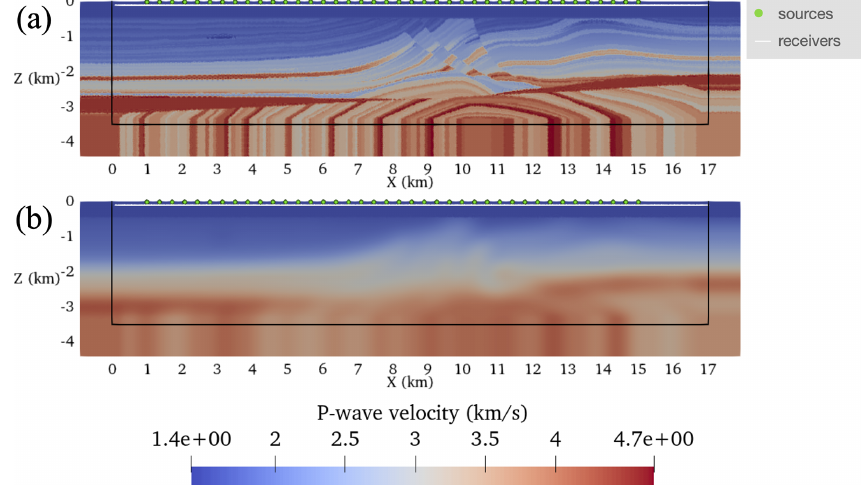
Figure 15. The Marmousi2 model setup described in Sect. 5.4. Panel (a) shows the target model, and panel (b) shows the guess velocity model. On both panels, sources and receivers are annotated. The (cid:127) 0 is the region inside the solid black line.